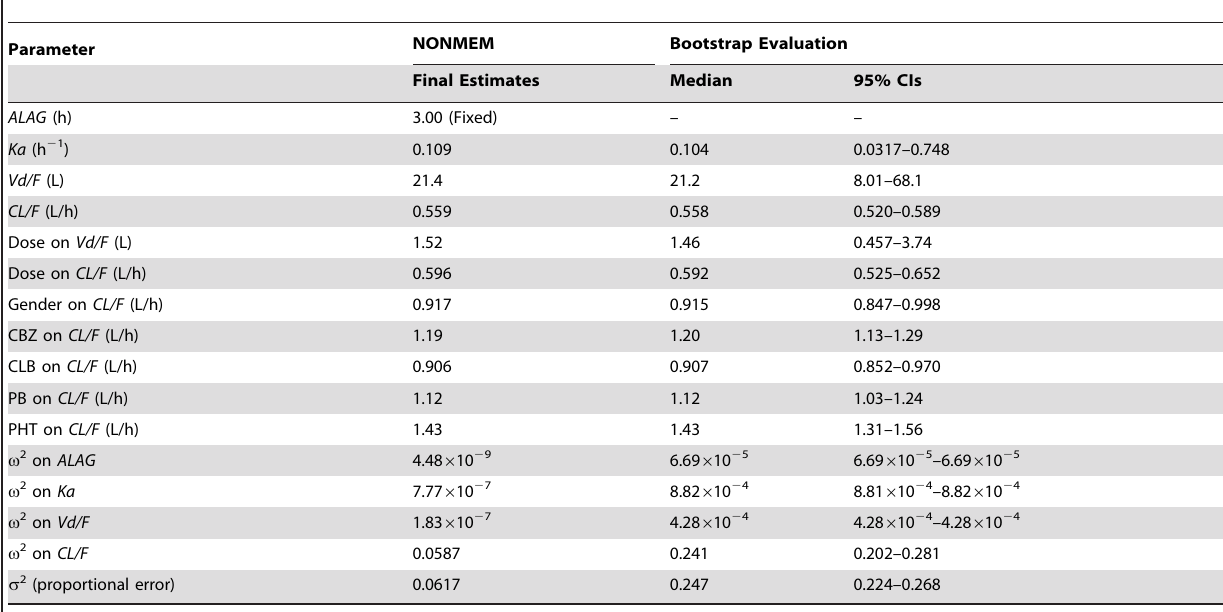
Table 2. The median values of the PK parameter estimates of VPA in the final population PK models obtained using the NONMEM program and the bootstrap